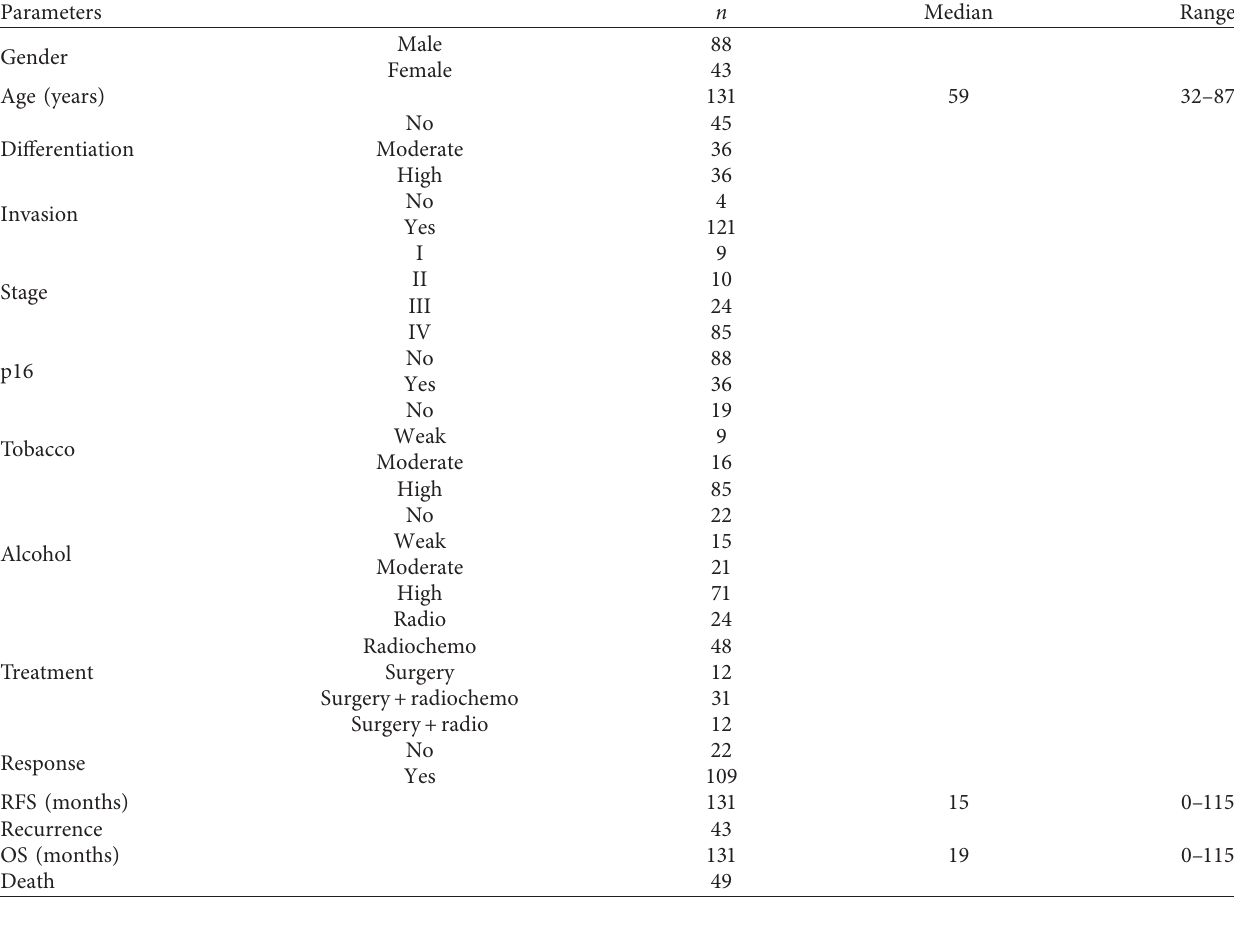
Table 1: Characteristics of the OSCC patients ( n �